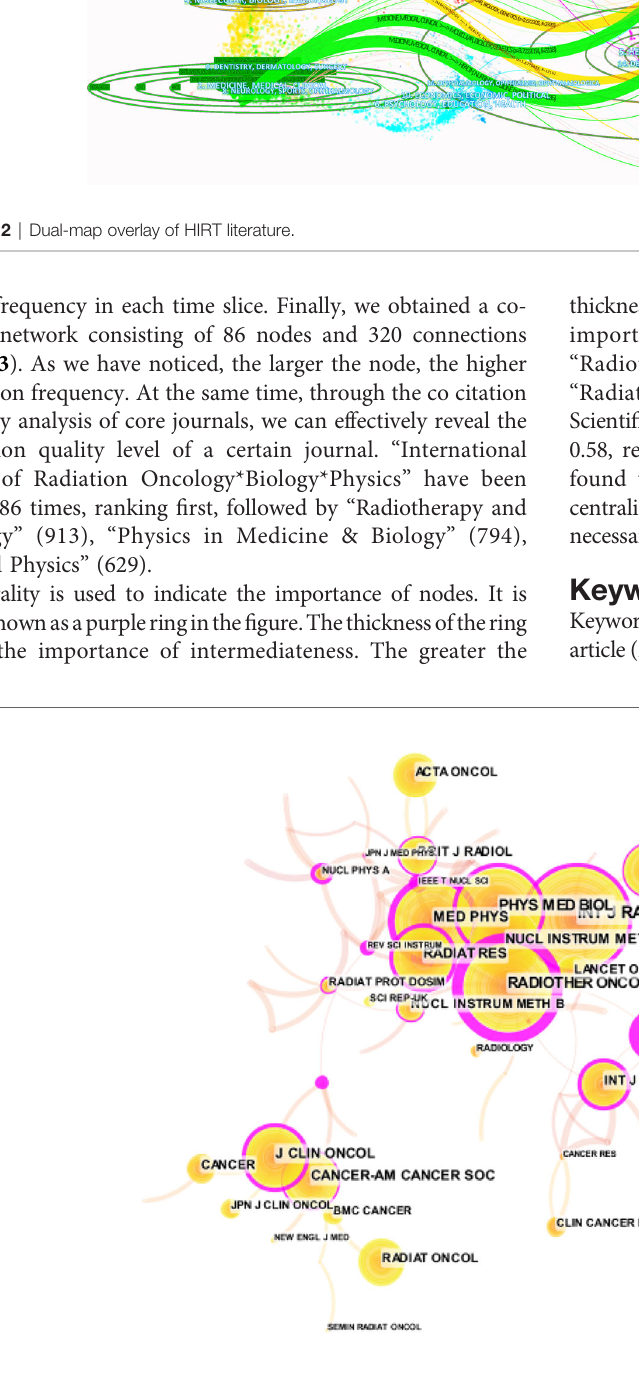
FIGURE 3 | Co-cited analysis of journals related to HIRT literature.